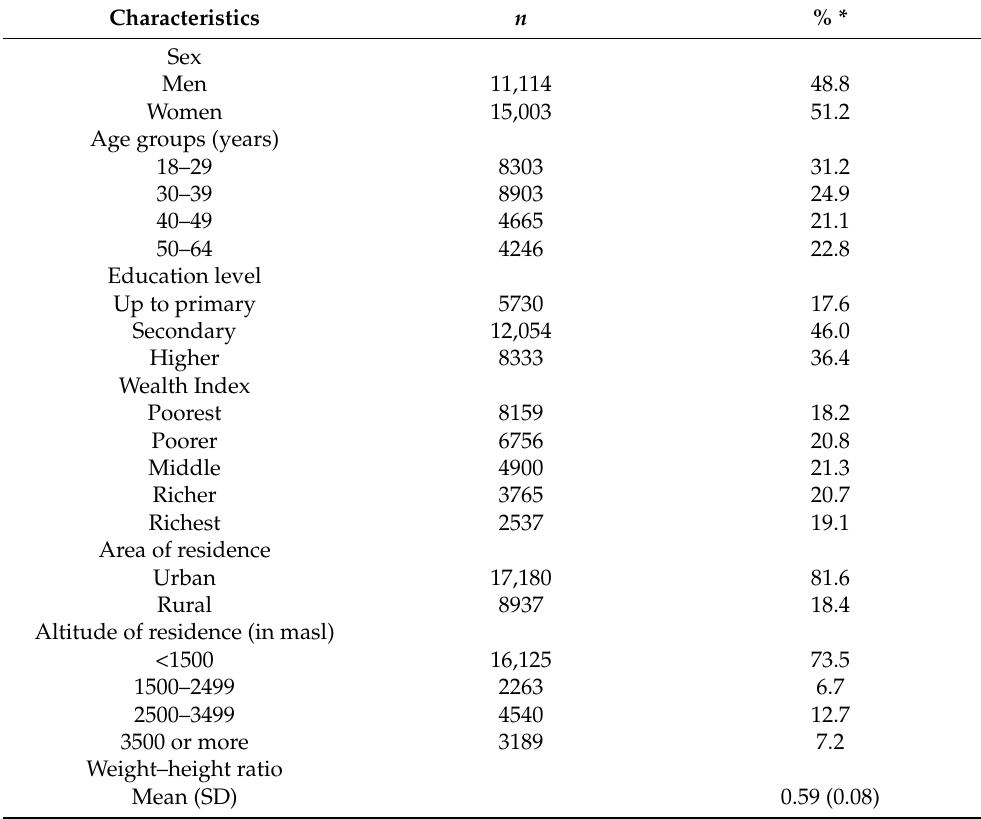
Table 1. Characteristics of the participants included in the study ( n =